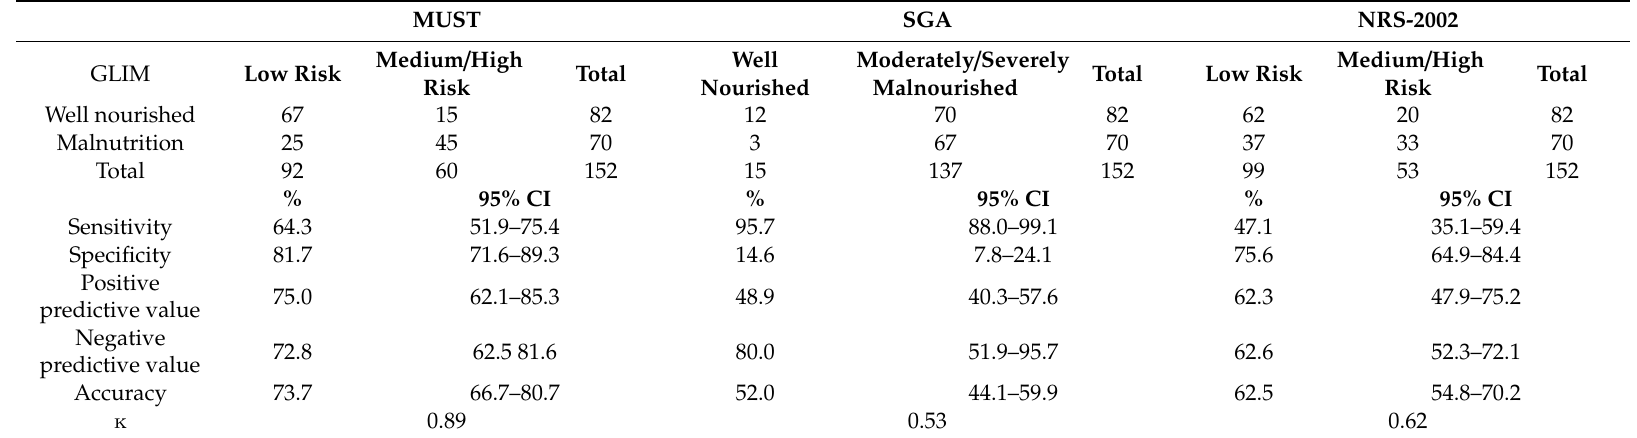
Table 3. Statistical comparison of nutritional diagnosis and screening tools values at hospital